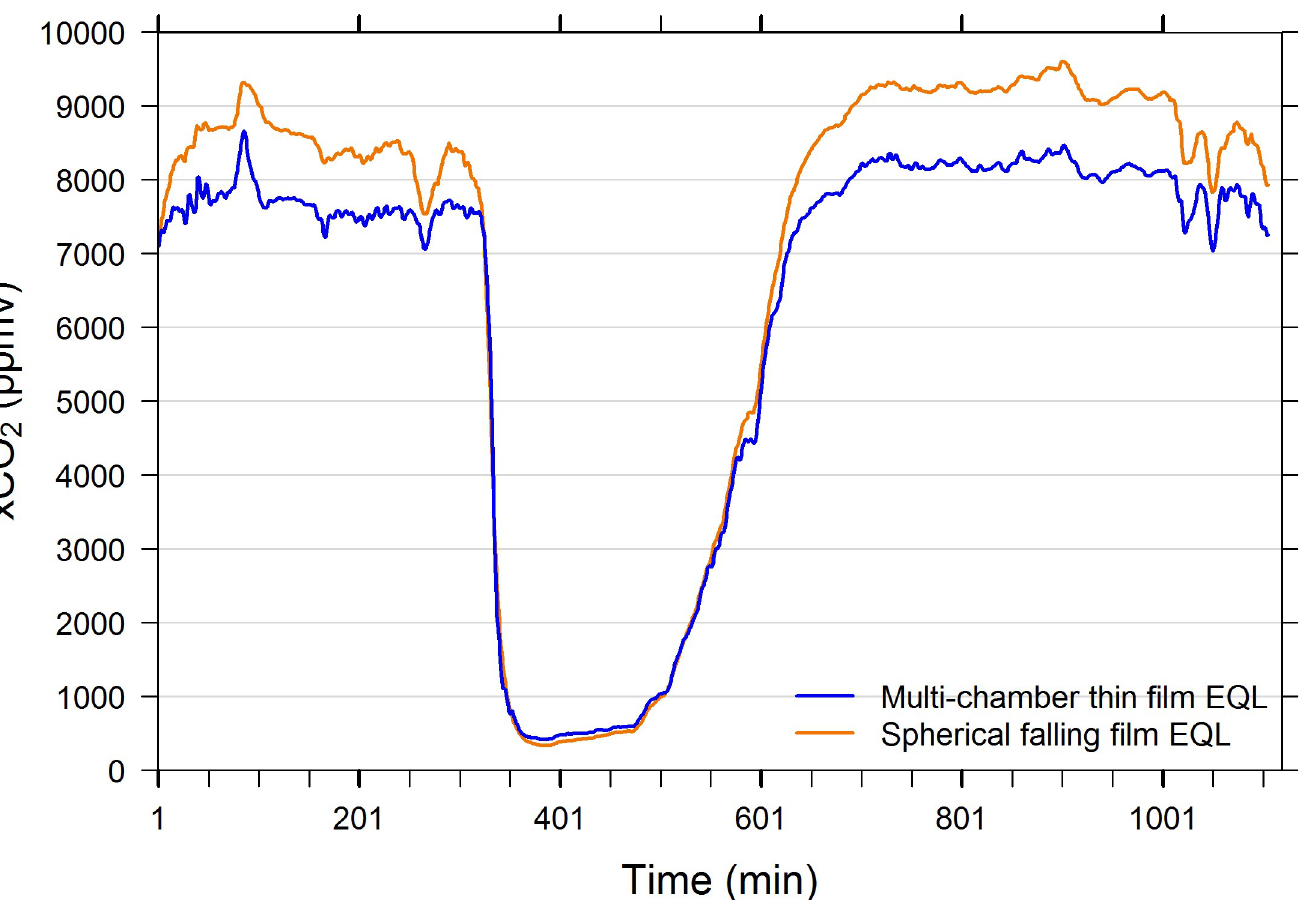
Fig 11. Side-by-side field measurements of multi-chamber thin film open loop and 8-in spherical falling film closed loop EQLs. Measurements were made autonomously at 1-min intervals February 27–28, 2017 in the tidal creek that drains the Kirkpatrick tidal marsh in the Rhode River, Edgewater, MD. This system is tidally driven, and CO 2 -rich water is drained during low tides. The spherical falling film EQL consistently measured substantially higher xCO 2 values than the multi- chamber thin film EQL during low tides, and slightly lower values during high tide (mean difference ± SD = 662.7 ± 427.7 ppmv, n = 1106).